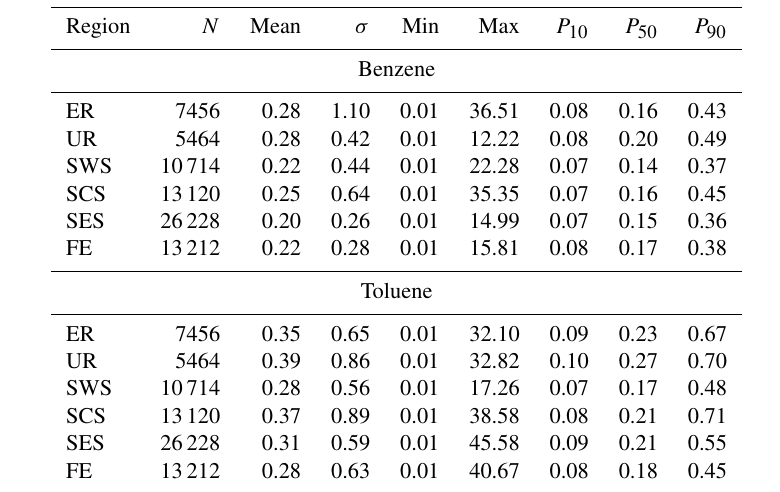
Table 2. The regional statistics of benzene, toluene (in ppb) and T / B along the Trans-Siberian Railway: ER – European Russia; UR – Ural Mountains region; SWS – southern parts of west Siberia; SCS – southern parts of central Siberia; SES – southern parts of east Siberia; FE – Far East region.